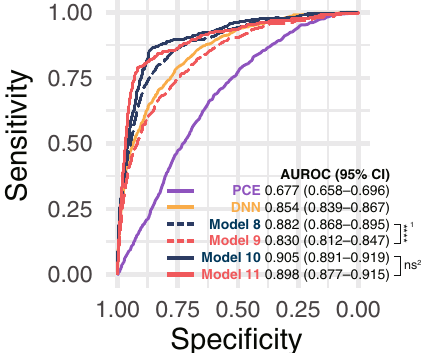
Fig. 4 Receiver operating characteristic curves in the external validation set. The performances of the models (Models 6 – 11) are described in Table 2. The models were trained with multimodal data in the SMC dataset. 1 The difference in AUROCs between Models 8 and 9 is signi fi cant (p-value < 2 × 10 − 16 ). 2 The difference in AUROCs between Models 10 and 11 is not signi fi cant ( p -value = 0.578). AUROC Area under the receiver operating characteristics curve, PCE Pooled Cohort Equation, DNN deep neural network, CRF clinical risk factors, SMC Samsung Medical SMC (Fig. 3b). Most ORs for the multimodal network (Model 5) were higher than those for DNN (Model 3). When the multimodal model was trained with all SMC data, the AUROC in the external validation increased further (Model 8 vs. Model 5).